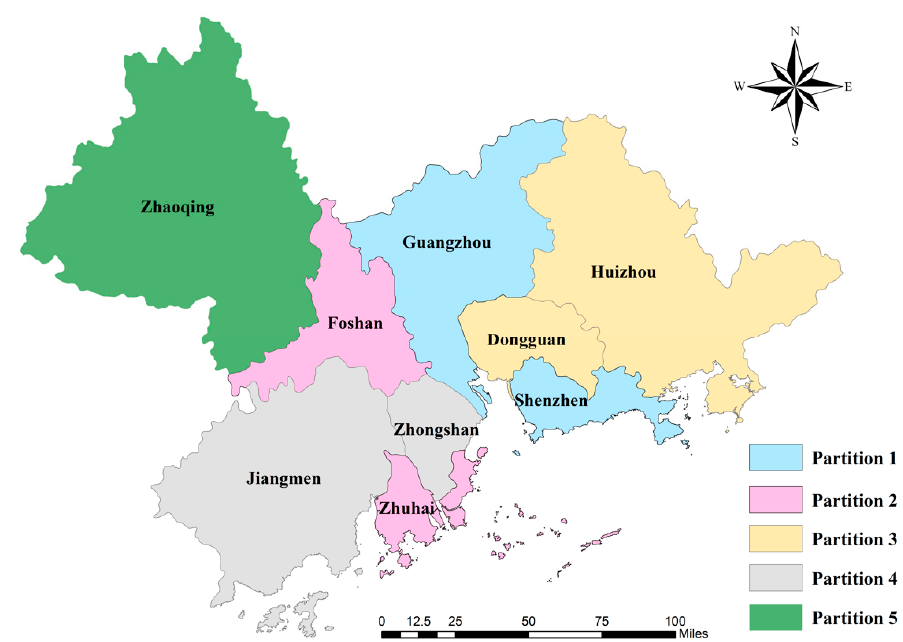
Figure 4. The partition for Pearl River